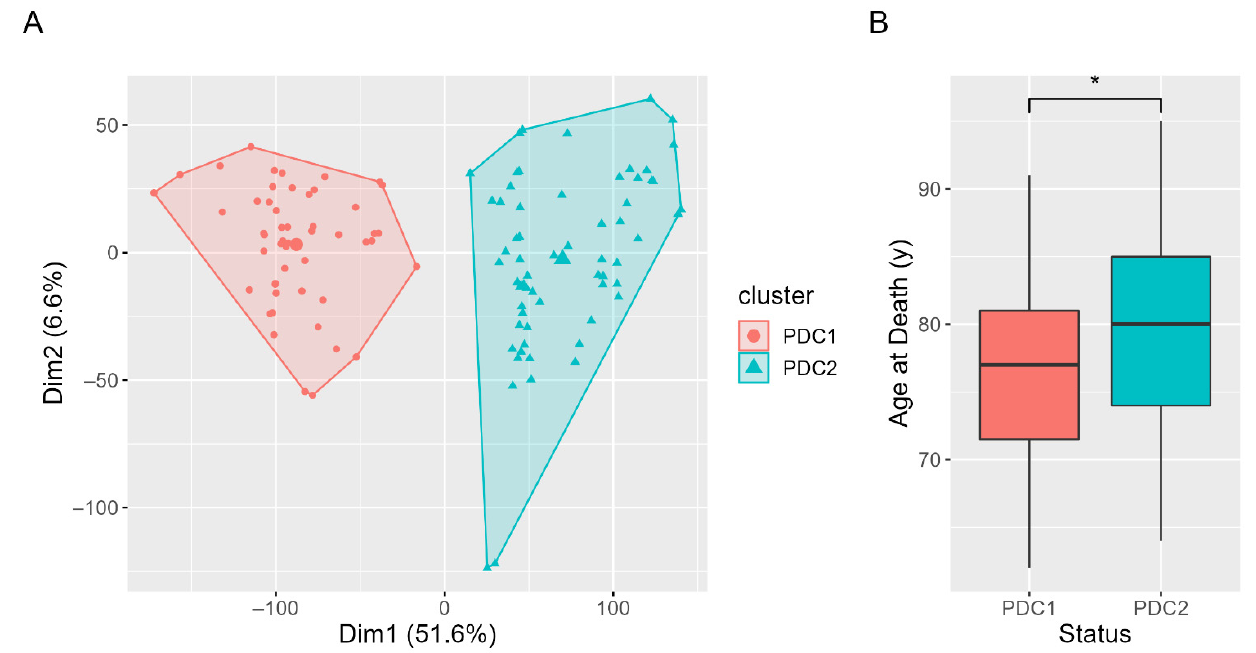
Figure 1. Clustered subjects and clinical characterization. ( A ) PCA plot for RNA-Seq data, clearly showing PDC1 and PDC2 separation. ( B ) Boxplot for PDC1 and PDC2 age at death, reporting a significant difference * p value <